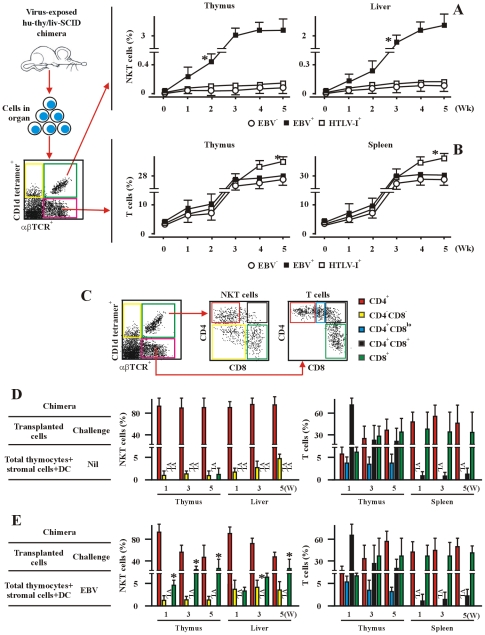
EBV promotes CD8+ NKT cell development in vivo in hu-thy/liv-SCID chimeric mice.(A) and (B) Development of total NKT (A) and T cells (B). The frequencies of NKT cells and T cells in thymus, liver, and spleen from hu-thy/liv-SCID chimeras challenged i.t. with EBV (EBV+) or HTLV-1 (HTLV-1+), were assessed by flow cytometry (middle and right panels) at the indicated timepoints. Unchallenged hu-thy/liv-SCID chimeras (Nil) were used as controls. Empty CD1d tetramer and isotype matched control Abs, which were used as staining controls, were not illustrated in this figure. The experimental and analysis scheme was shown in the leftmost panel. Data were mean ± s.d. (n  =  8). *, p<0.001. EBV-challenged chimeras vs. non-challenged or HTLV-1-challenged chimeras. (C) The experimental and analysis scheme for detecting the co-receptor-expressing NKT cells and T cells in various organs from different hu-thy/liv-SCID chimeras was illustrated. The α-GalCer-loaded CD1d tetramer, αβTCR mAb and other relevant mAbs were used to identify the different subsets of NKT cells and T cells as illustrated. The appropriate isotype Abs and empty fluorochrome-conjugated CD1d tetramer were used as controls. (D) and (E) Data showed the frequencies of co-receptor-expressing NKT cells and T cells in the unchallenged (D, Nil) or EBV challenged (E, EBV) hu-thy/liv-SCID chimeras. The protocols for the establishment of the chimeras were described in the leftmost panels. The chimeras were sacrificed at the indicated time intervals following post-immune-reconstitution and viral challenge and the various organs and tissues were collected. +DC, thymic DCs were included. VL, very low level (below detectable levels). Data were mean ± s.d. (n  =  7). *, p<0.001, EBV-challenged chimeras vs. non-challenged or HTLV-1-challenged chimeras.